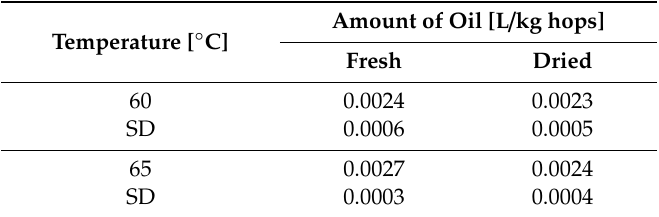
Table 4. Amount of oil extracted in L / kg with standard deviations (SD) for prior and after drying process. Amount of Oil [L / kg Temperature [ ◦ C]